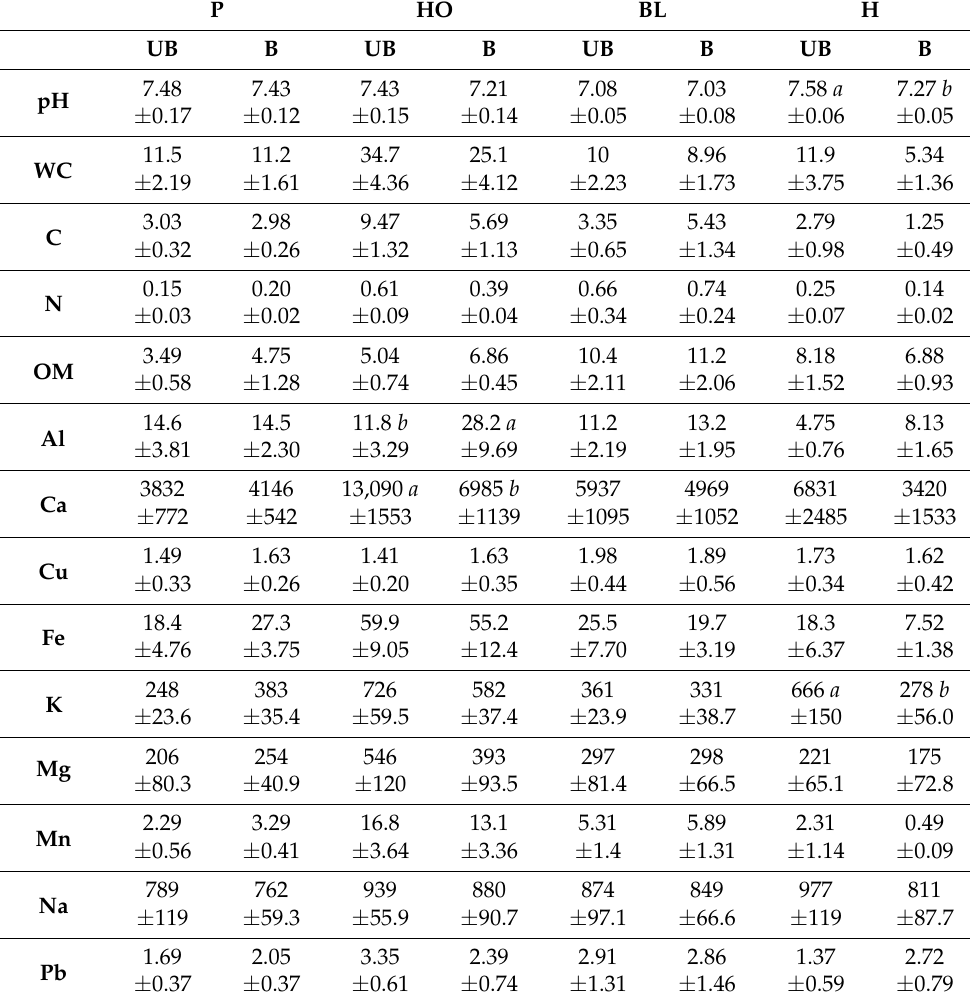
Table 3. Abiotic properties of unburnt and burnt soils under different vegetation covers. Mean values ( n = 12, ± s.e.) of pH, water content (WC, expressed as % d.w), C and N concentrations (expressed as % d.w.), organic matter content (OM, expressed as % d.w.), and Al, Ca, Cu, Fe, K,